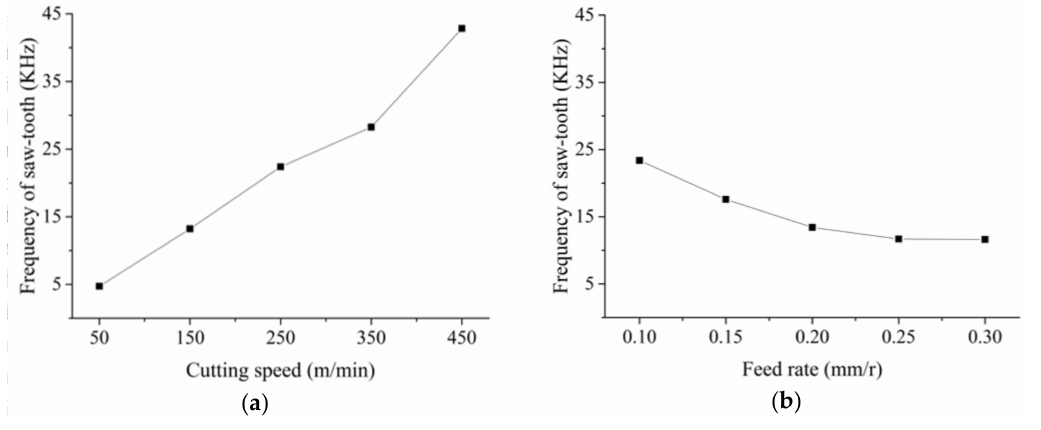
Figure 8. Effect of the cutting speed and the feed rate on the frequency of the saw-tooth: ( a ) f r = 0.2 mm/r, a p = 0.4 mm; ( b ) v s = 150 m/min, a p = 0.4 mm.